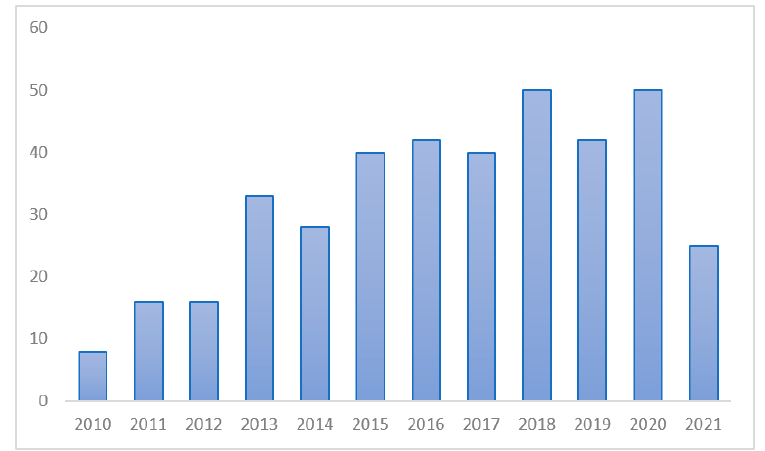
Figure 2. Number of